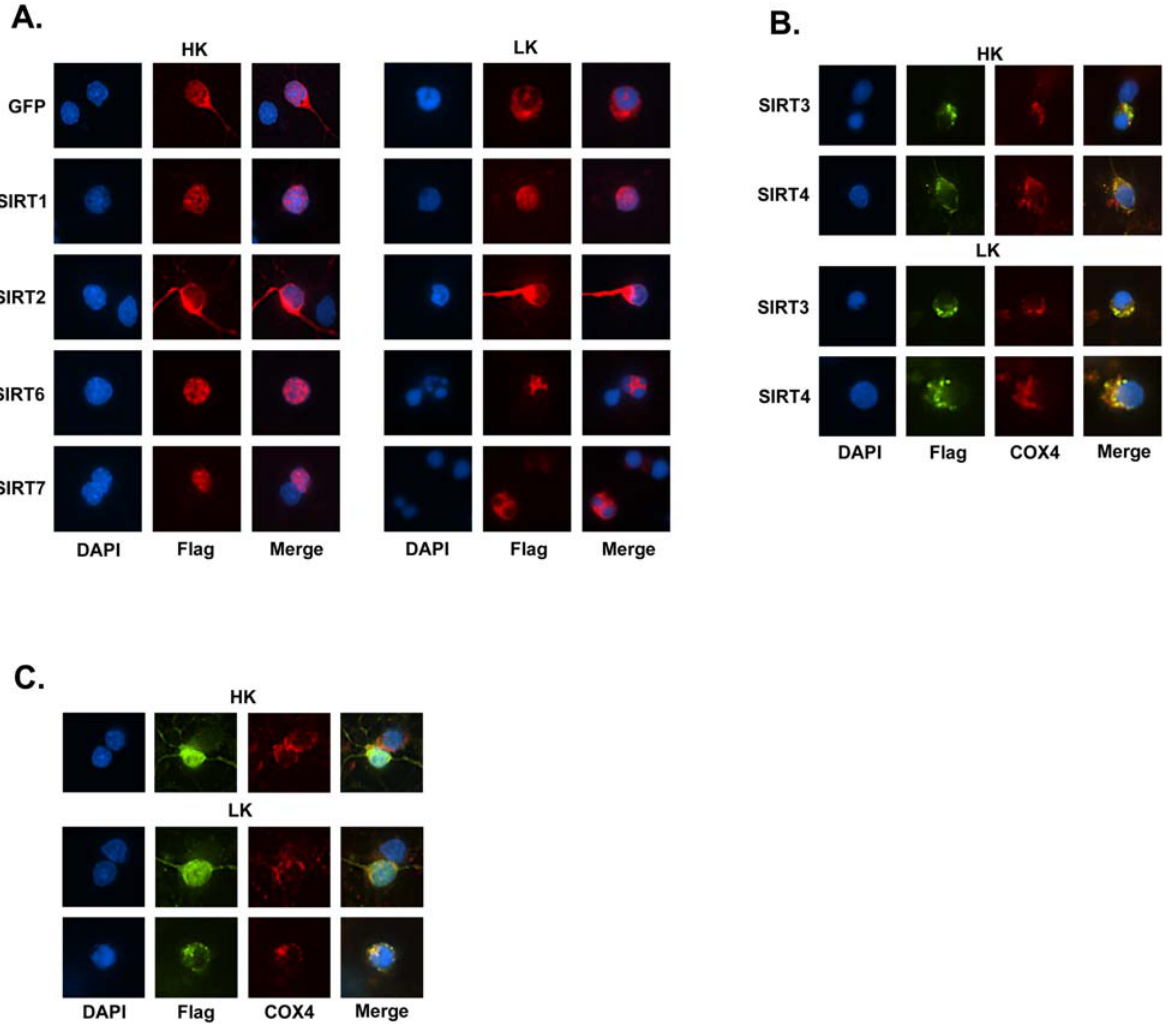
Figure 2. Subcellular localization pattern of SIRT 1–7 in neurons. Expression plasmids encoding Flag-tagged forms of SIRT 1–7 were transfected into CGNs and the cultures were switched to HK or LK medium. The localization of each sirtuin was visualized by immunocytochemistry using a Flag antibody. DAPI staining was used to label the nucleus. In some cases, Cox4 antibody was used to visualize mitochondria. Images were obtained with a Nikon Eclipse 80i using a 60 6 objective. (A) Subcellular localization of SIRT1, SIRT2, SIRT6, and SIRT7 in HK and LK-treated neuronal cultures. Non-apoptotic cells were used for SIRT2 and SIRT6 in HK to show localization. (B) Mitochondrial localization of SIRT3 and SIRT4. The punctate pattern of SIRT3 and SIRT4 correspond to mitochondrial localization as evidenced by the overlap with Cox4 immunostaining. (C) Subcellular localization of SIRT5 in CGNs. In HK treatment SIRT5 predominately localizes to the cytoplasm, mitochondria, and nucleus (HK panel) while in LK SIRT5 can localize to the cytoplasm, mitochondria, and nucleus (upper LK panel) or to mitochondria (lower LK panel). Mitochondrial localization of SIRT5 is associated with apoptosis.